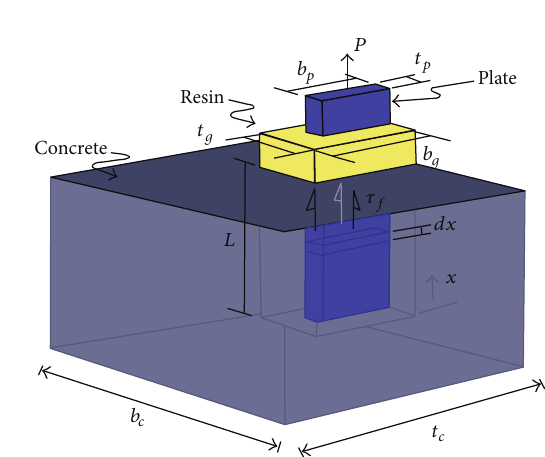
Figure 1: Simplified model of